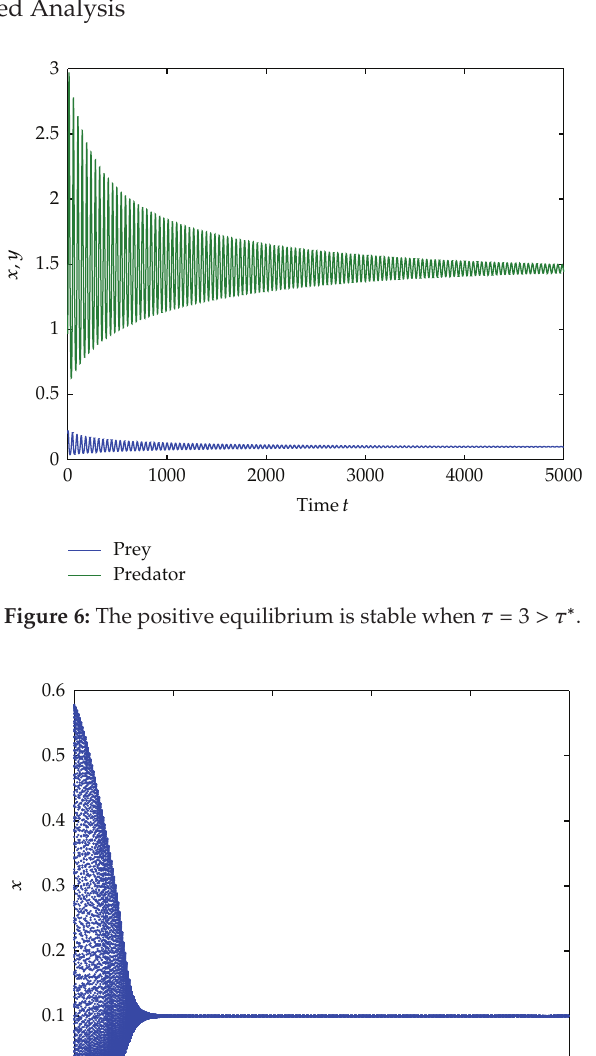
Figure 6. In Figures 7 and 8, we plot the relationship between delay τ and ultimate amplitudes of x (cid:2) t (cid:5) and y (cid:2) t (cid:5) , which indicate the fact that the positive equilibrium E is from instability to stability as τ